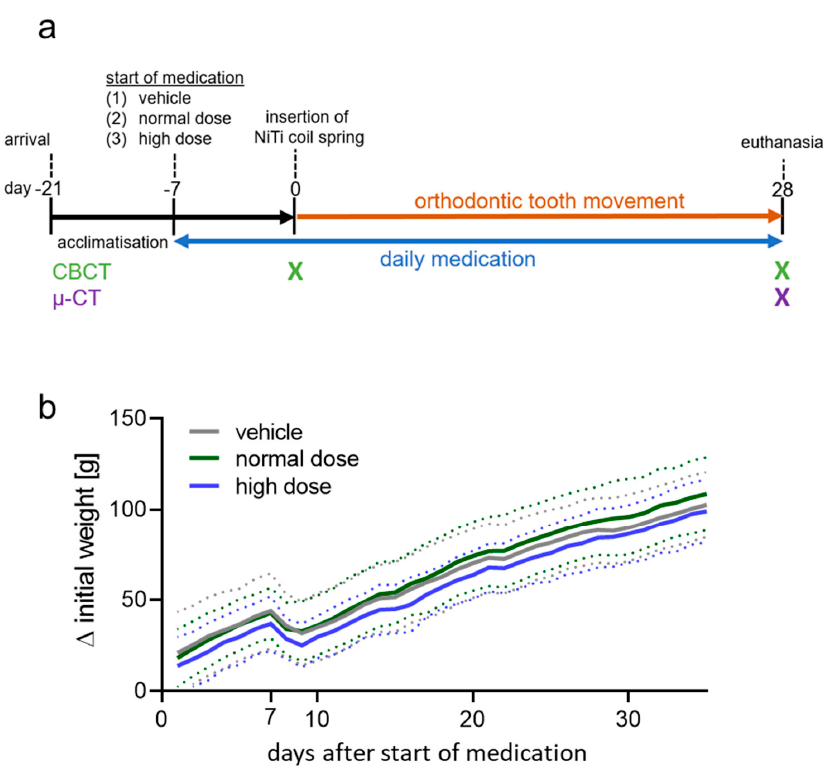
Figure 1. ( a ) Experimental time-flow chart of the animal experiment. ( b ) Weight di ff erence to initial gross body weight of rats treated with tap water (vehicle), normal or high dose cetirizine. Solid line: mean values; dashed line: standard deviation. n ≥ 19. Statistics: Welch-corrected ANOVA followed by Games–Howell multiple comparison